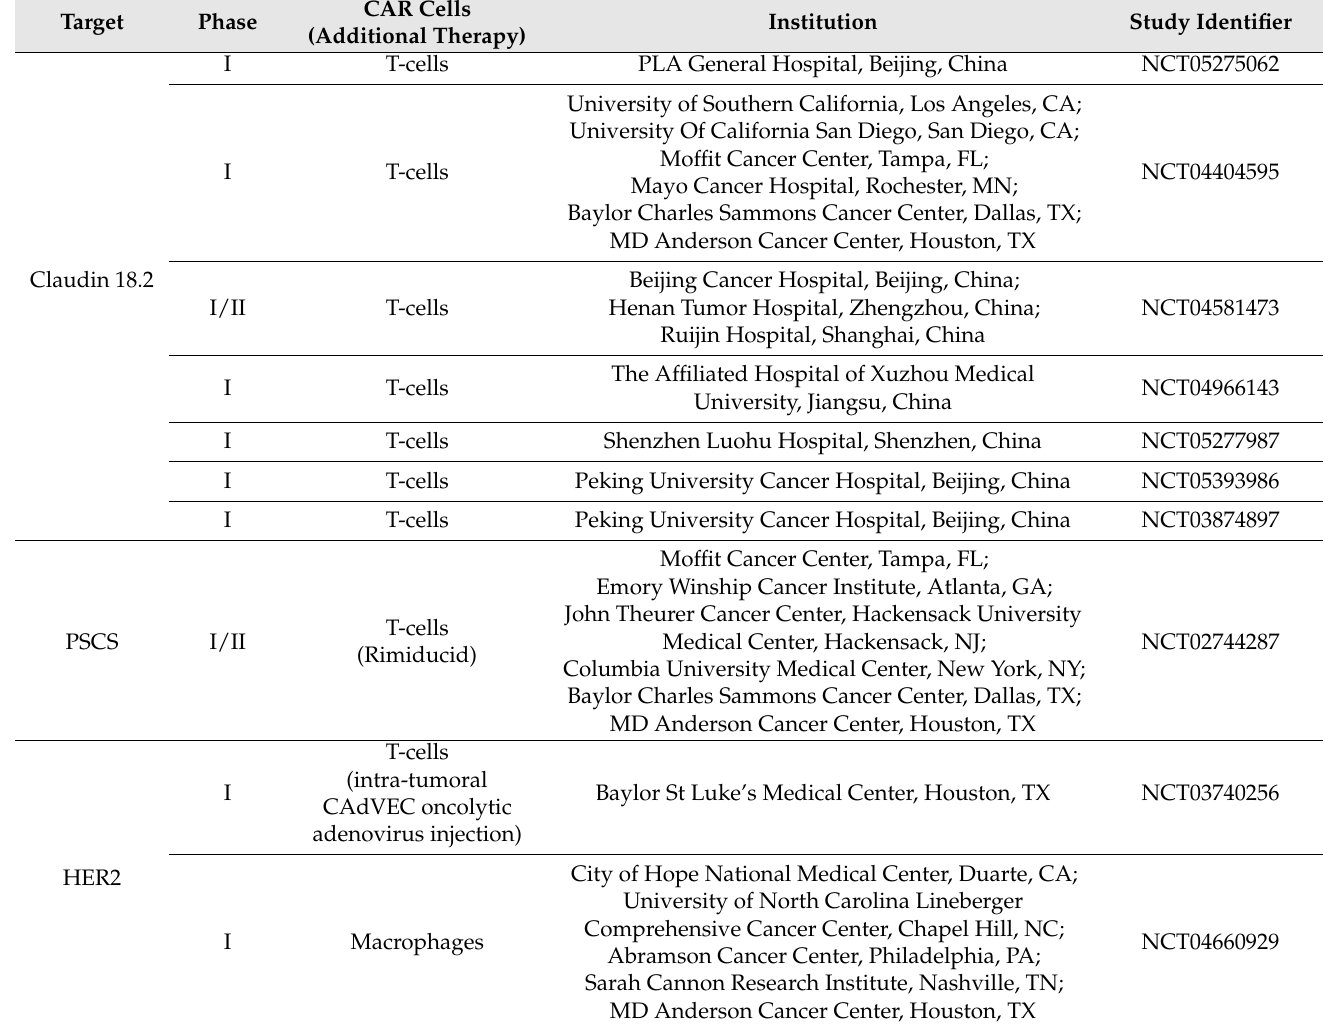
Table 3. Ongoing CAR Trials in